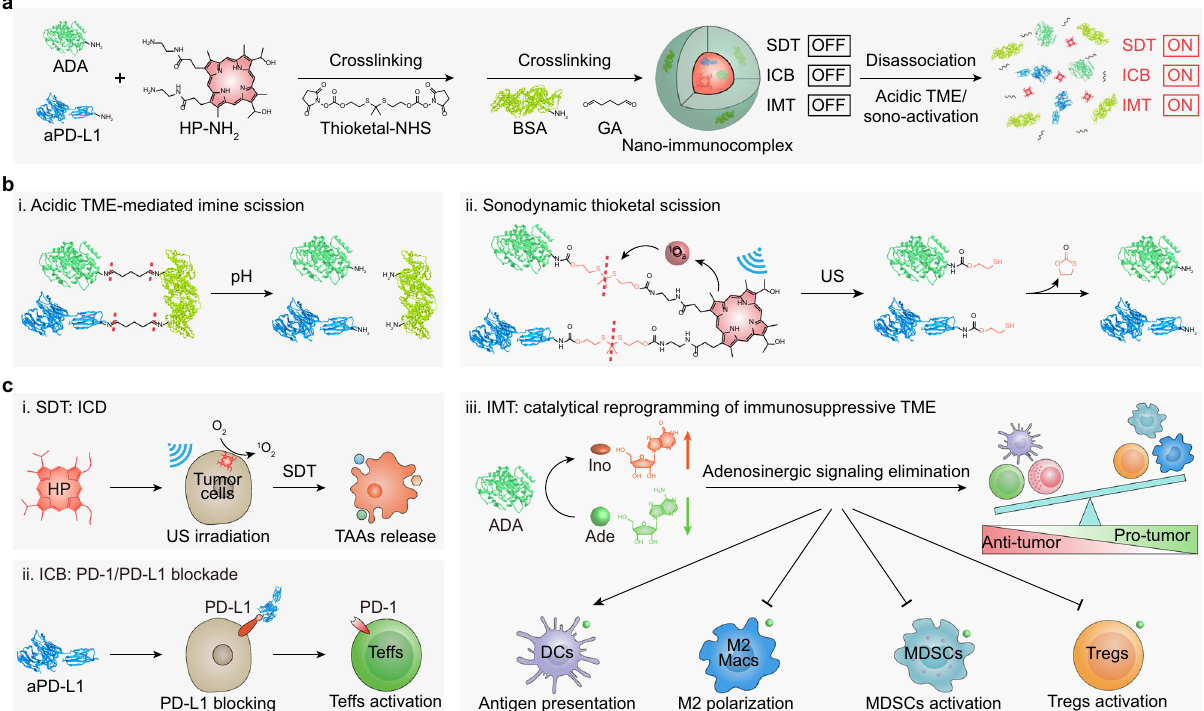
Fig. 1 Schematic illustration of the smart catalytical nano-immunocomplex for remote-controlled sono-metabolic checkpoint trimodal cancer therapy. a Synthesis and activation of the nano-immunocomplex for synergistic sonodynamic therapy (SDT), immune checkpoint blockade (ICB), and immunometabolic therapy (IMT). b Acidic TME/sono-activatable molecular scission mechanisms of the nano-immunocomplex. (i) Acidic TME-mediated scission of imine bond. (ii) Sonodynamic scission of thioketal bond. c Acidic TME/sono-activatable cancer therapeutic mechanisms of the nano- immunocomplex. (i) Hematoporphyrin (HP)-mediated SDT to induce 1 O 2 generation, immunogenic cell death (ICD), and tumor-associated antigens (TAAs) release. (ii) aPD-L1-mediated ICB for effector T cells (Teffs) activation via blocking PD-1/PD-L1 signaling pathway. (iii) Adenosine deaminase (ADA)-mediated IMT to promote the antigen presentation of dendritic cells (DCs), reduce the protumorigenic polarization of M2 macrophages (M2 Macs), and inhibit the activation of myeloid-derived suppressor cells (MDSCs) and regulatory T cells (Tregs) via the elimination of adenosinergic pathway by catalytical conversion of adenosine (Ade) to inosine (Ino) for immunosuppressive TME